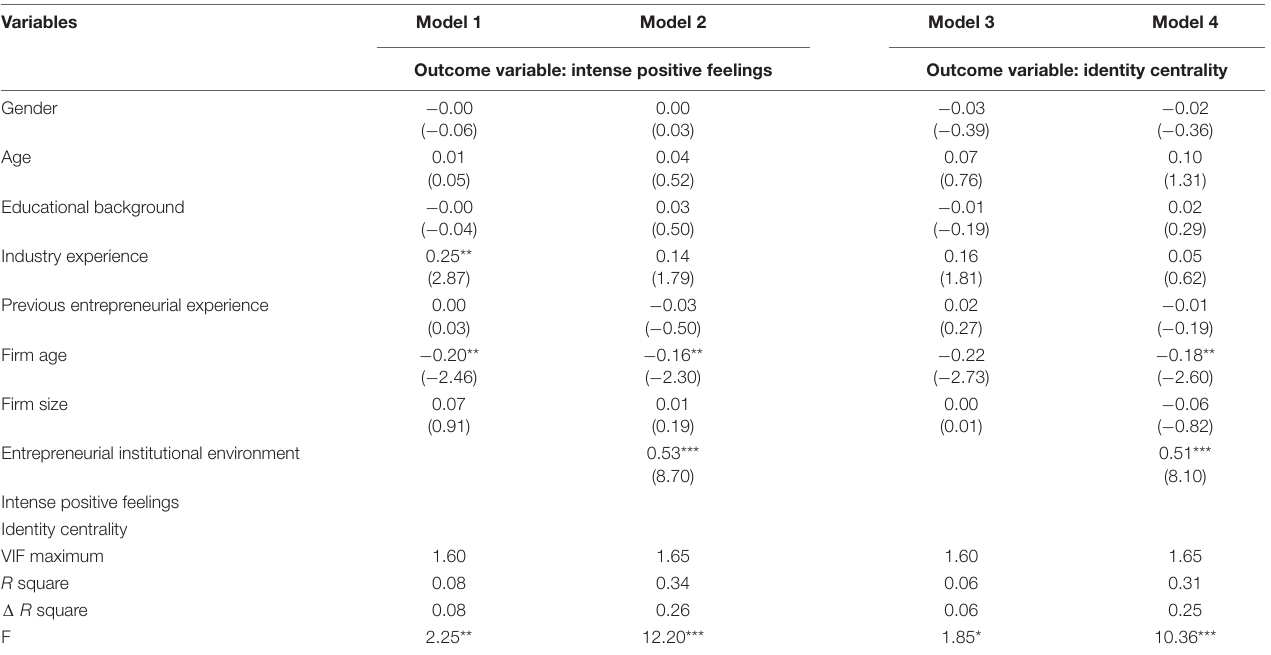
TABLE 5 | Regression analysis of direct